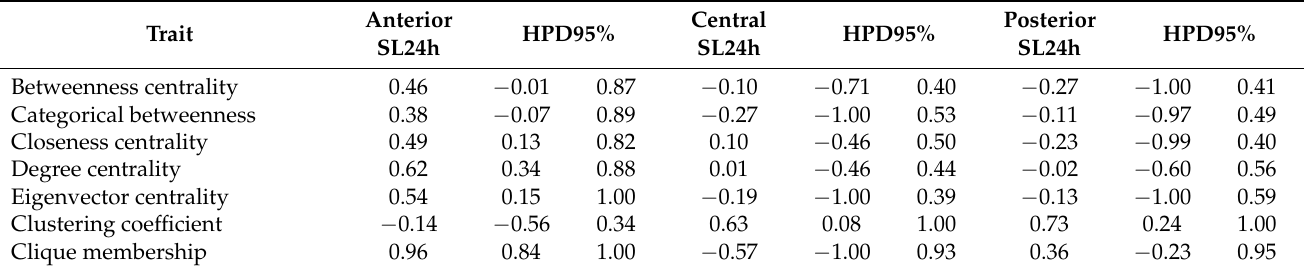
Table 5. Posterior means of the genetic correlations and the 95% highest posterior density intervals (HPD95%) of social network analysis traits for aggressive behaviour and skin lesions recorded 24 h post-mixing (SL24h).